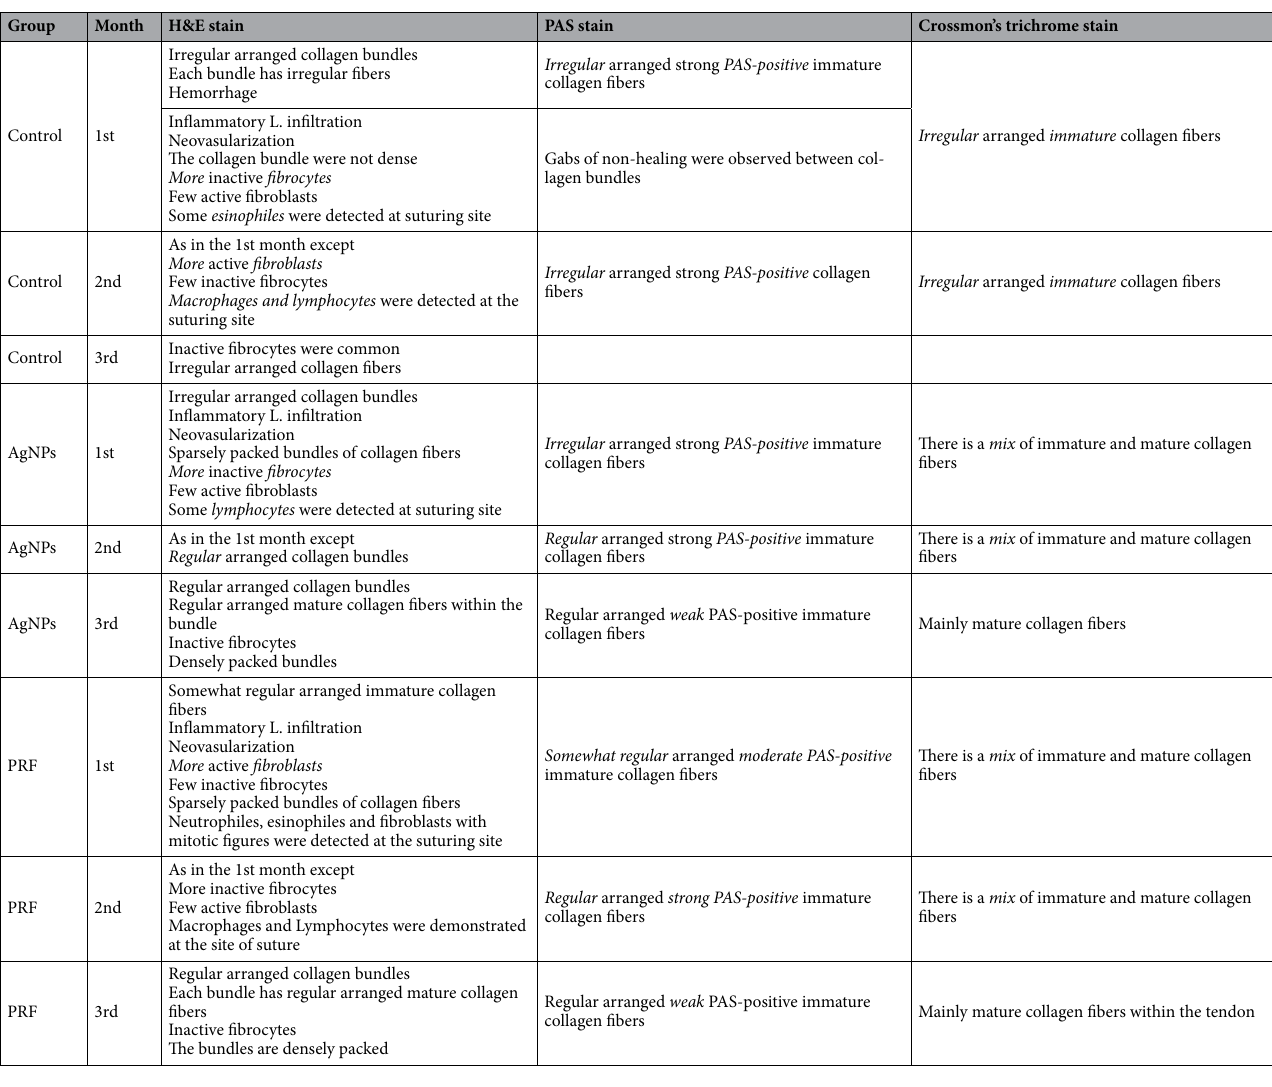
Table 2. The histopathological findings of the different groups at different times using three different